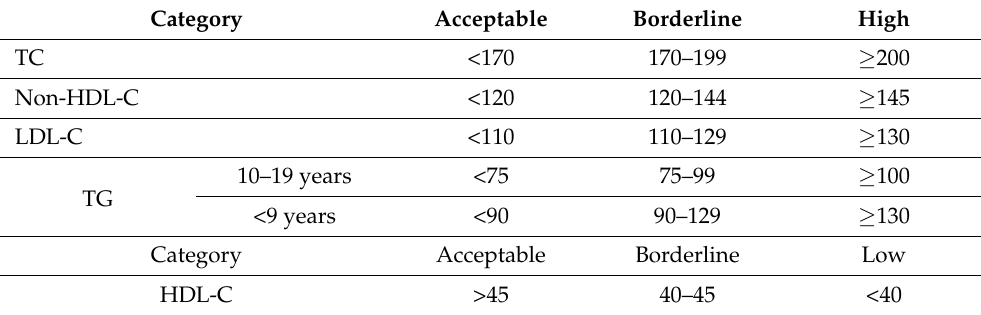
Table 3. Plasma lipid values in pediatric age and related percentiles. Adapted by NLHBI Integrated Guidelines for Cardiovascular Health and Risk Reduction in Children and Adolescents (peds_ guidelines_full.pdf